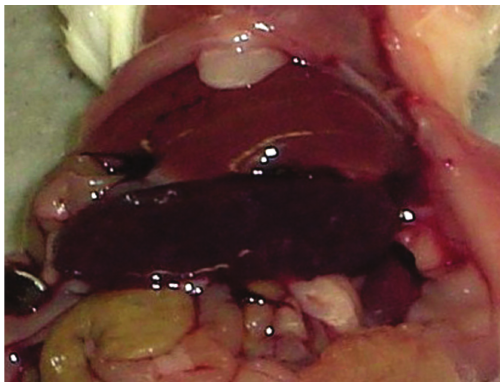
Figure 2: BALB/c mouse i.p. infected with 10 6 CFU of Brucella ovis ATCC25840 with severe splenomegaly at 30 days of infection.